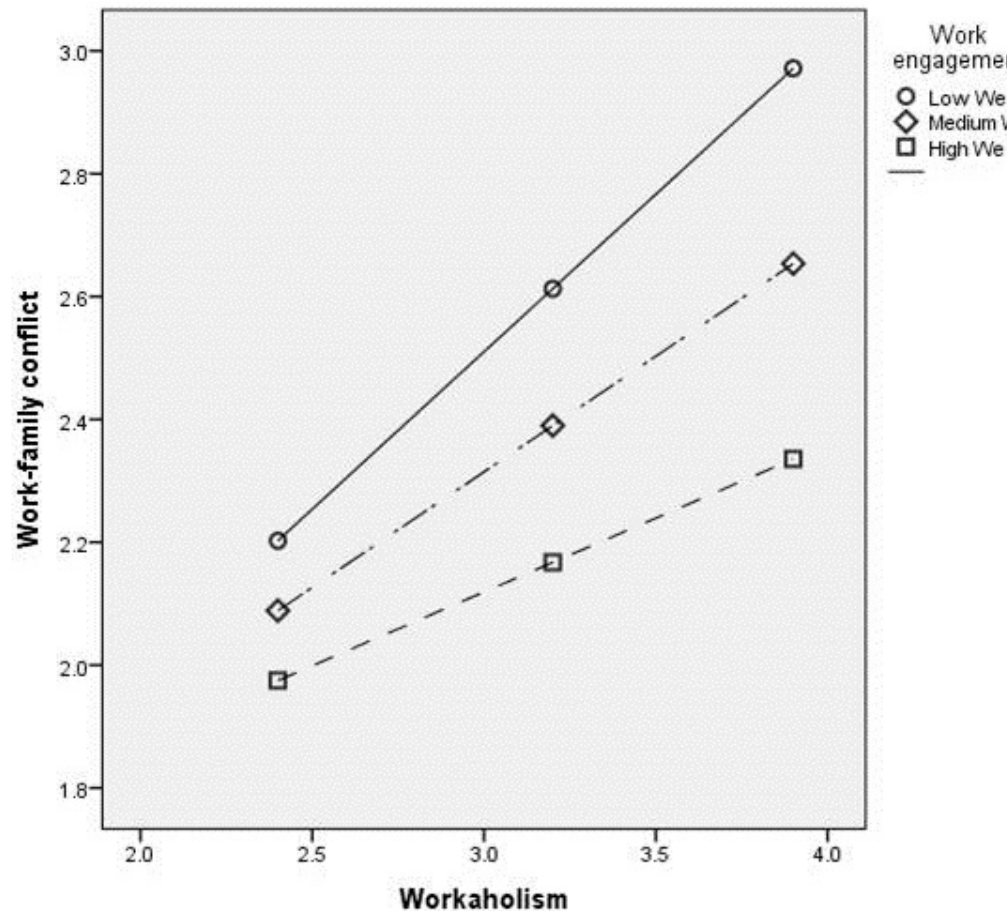
Figure 2. Plot of the interaction between workaholism and work engagement on work–family conflict.